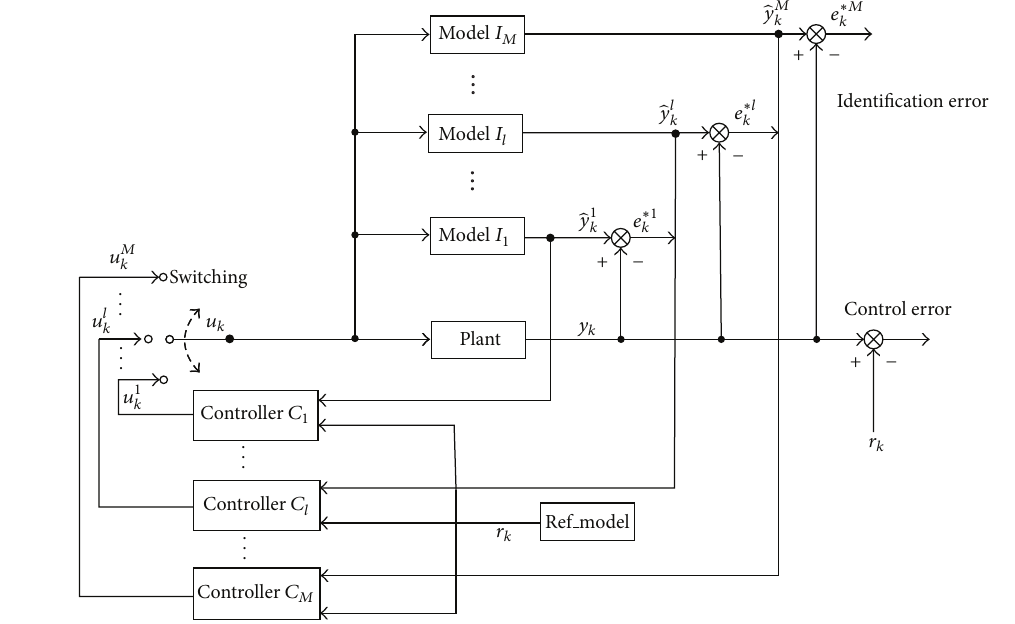
Figure 2: Structure of multiple models adaptive control.